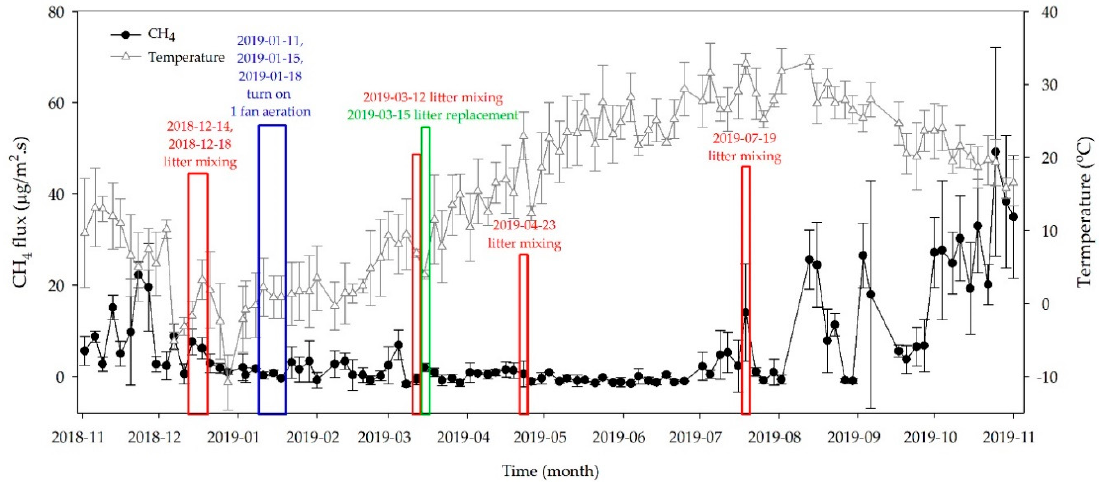
Figure 4. Variation in average CH 4 flux from litter on the day of sampling during the study (error bars represent the standard deviation of the average).